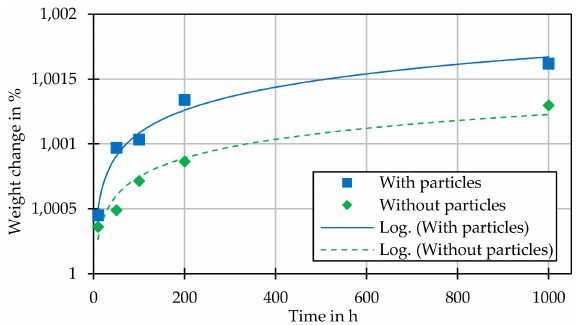
Figure 10. Influence of the graphite particles on the weight of the sample.